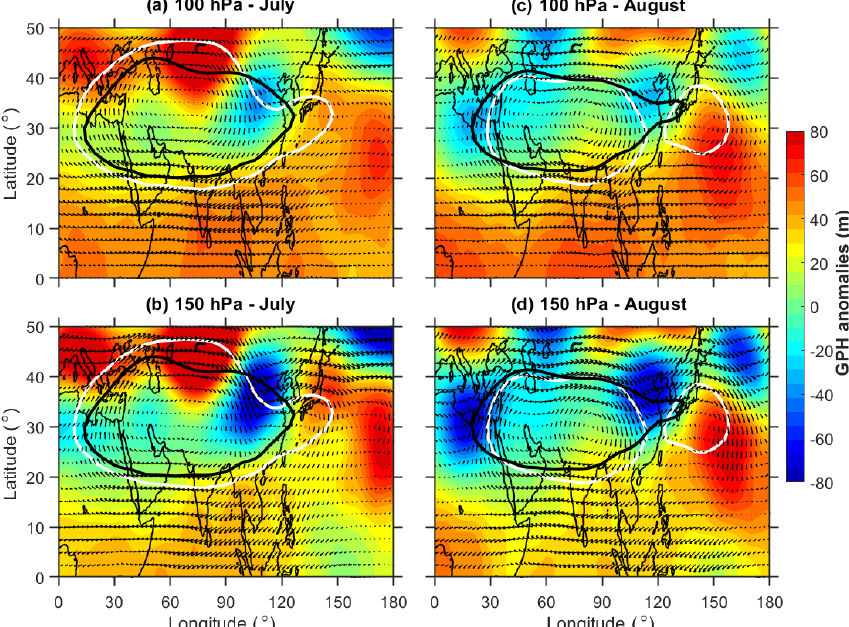
Figure 3. Spatial distribution of geopotential height anomalies obtained from NCEP-DOE Reanalysis 2 data during July 2015 (a) at 100hPa and (b) 150hPa superimposed with wind vectors at the respective corresponding levels. Subplots of (c) and (d) same as (a) and (b) but for the month of August. The solid white contour lines represent the ASMA region at 100hPa (16.75km GPH contour) observed in 2015 whereas the black color lines represent the mean of